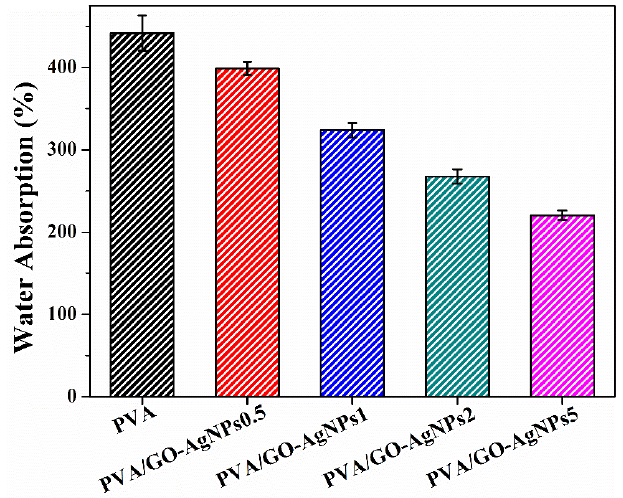
Figure 7. Water absorption of neat PVA and PVA / GO–AgNPs nanocomposites after 24 h immersed in deionized water at room temperature.